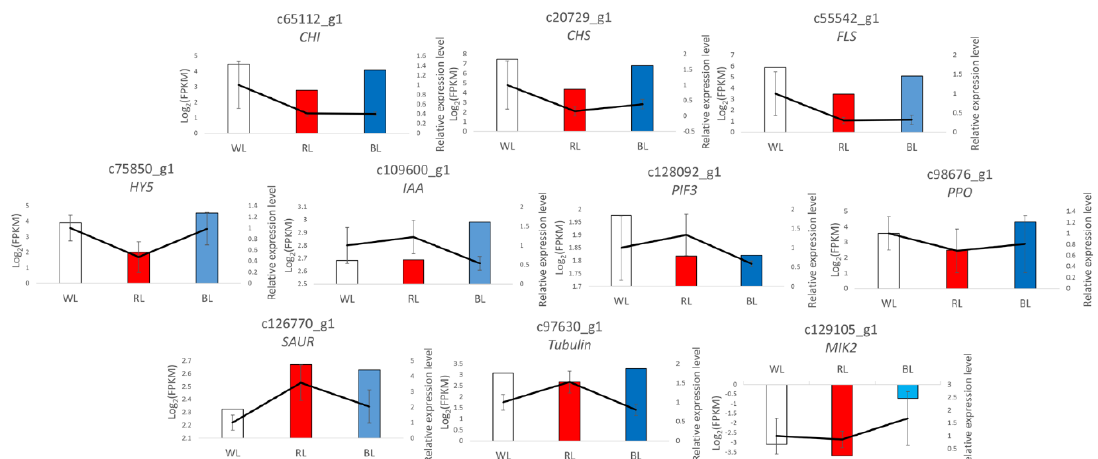
Figure 8. The expression results of ten randomly selected DEGs from RNA-seq and qRT-PCR in C. oleifera leaves under three light conditions. The y-axis on the left indicates the expression levels based on the RNA-seq data with Log2(FPKM) (histogram), whereas the y-axis on the right indicates the relative expression levels determined by qRT-PCR with fold-changes (black line chart). The x-axis indicates the light treatments. Data shown in mean value ± standard deviation (SD).